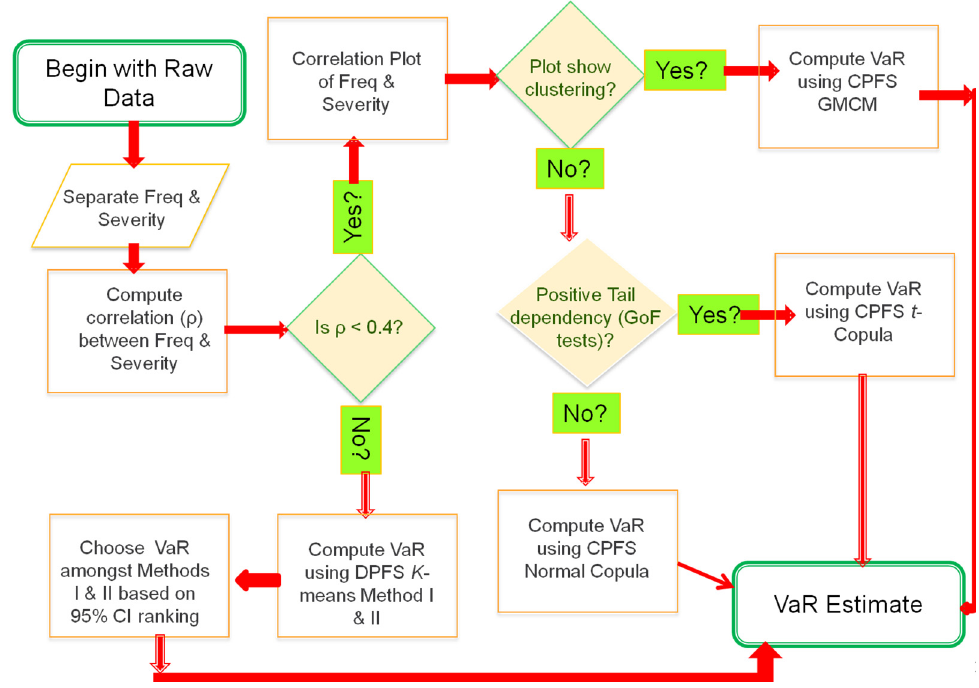
Figure 13. Flow ‐ chart for choosing the VaR estimation method. Here, Freq represents the Frequency component and the 95% CI represents the 95% bootstrap confidence intervals.